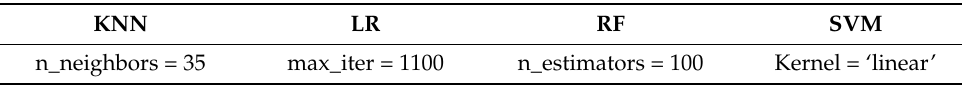
Table 1. Main parameter setting of KNN, LR, RF and